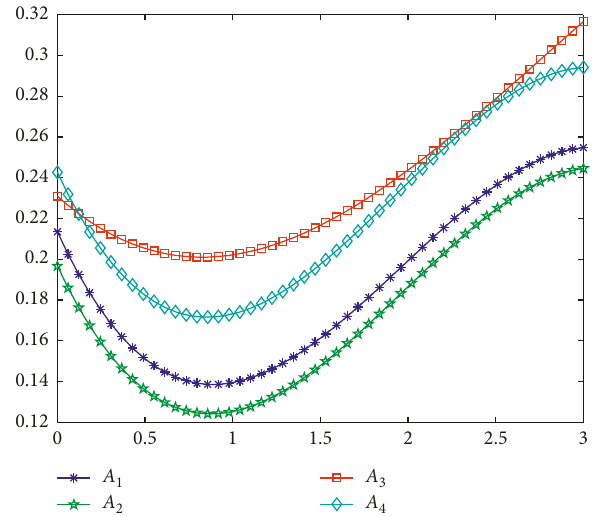
Figure 5: Variation of SC ( F operator ( p � 1 , q ∈ ( 0 , 3 ) ).